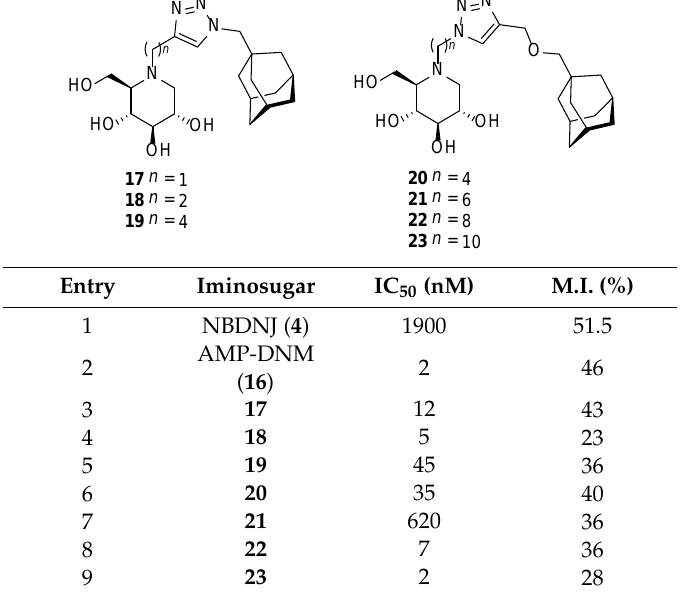
Figure 21. Effect of AMP-DNM derivatives on β -glucosidase activity in CF bronchial cells. CuFi-1 cells were treated with ( A – C ) 0.5 μM or ( D – F ) 5.0 μM of compound for 1 h before the measurement (adapted from